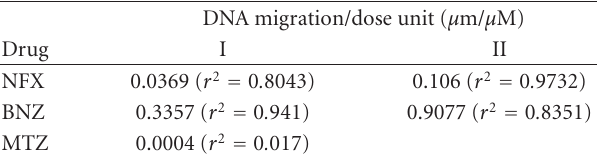
Table 2: Specific genotoxic activity of NFZ, BNZ, or MTZ on human leukocytes. I: alkaline comet assay; II: comet assay modified with ENDOIII for DNA oxidative